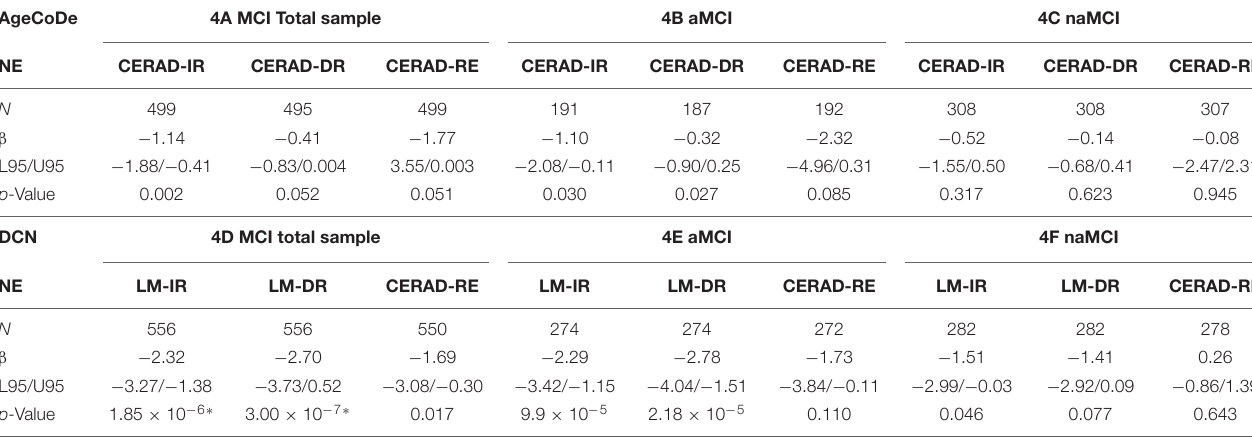
FIGURE 2 | Heat map visualization of associations between AD-associated SNPs and NEs of individuals with aMCI, including (1) orientation, (2) attention and working memory, (3) processing speed and executive functions, (4) language, (5) verbal learning and memory, (6) praxis, (7) visual gnosis, and (8) global cognition. Global orientation, summary of temporal + spatial + personal orientations; WAIS-III, Wechsler adult intelligence scale, third edition; SKT, Syndrome Kurz test; 15-BNT, the abbreviated Boston naming test with 15 items; Verbal learning WMS-III, 1st + 2nd + 3rd + 4th trial scores; WMS-III, Wechsler memory scale, third edition. TABLE 4 | Genetic associations with NE in the total sample, aMCI, and naMCI groups from AgeCoDe and DCN datasets. AgeCoDe 4C